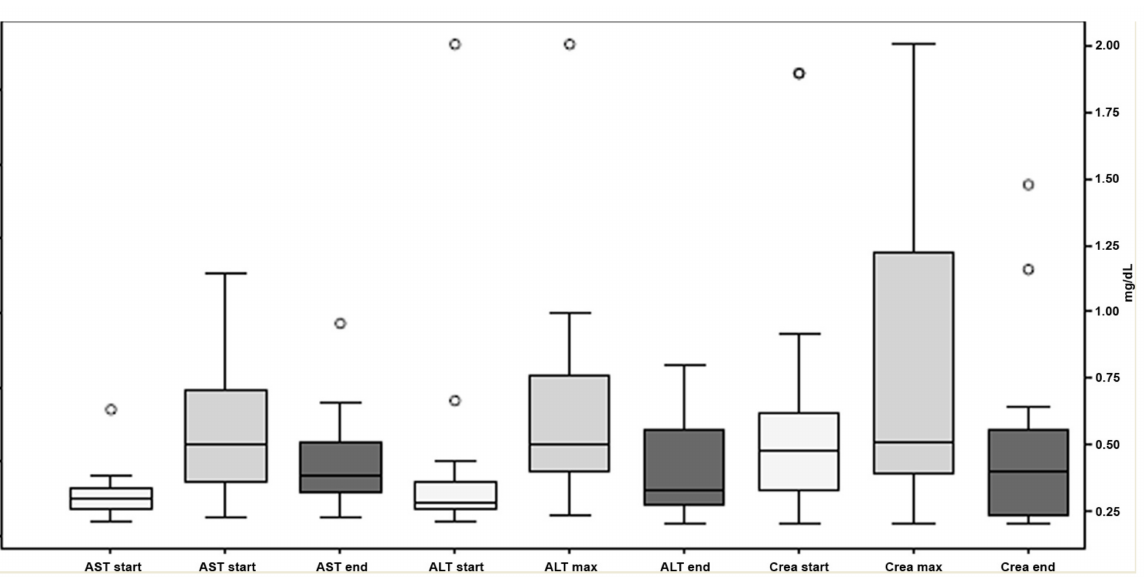
Figure 1. Plasma levels of aspartate transaminase (AST), alanine transaminase (ALT) and creatinine at baseline (white columns, start), maximum values during antifungal combination therapy (light grey columns, max), and at end of antifungal combination therapy (dark grey columns, end). The bars indicate the median, the boxes 25th and 75th percentiles and the whiskers the range. Outliers are indicated by the